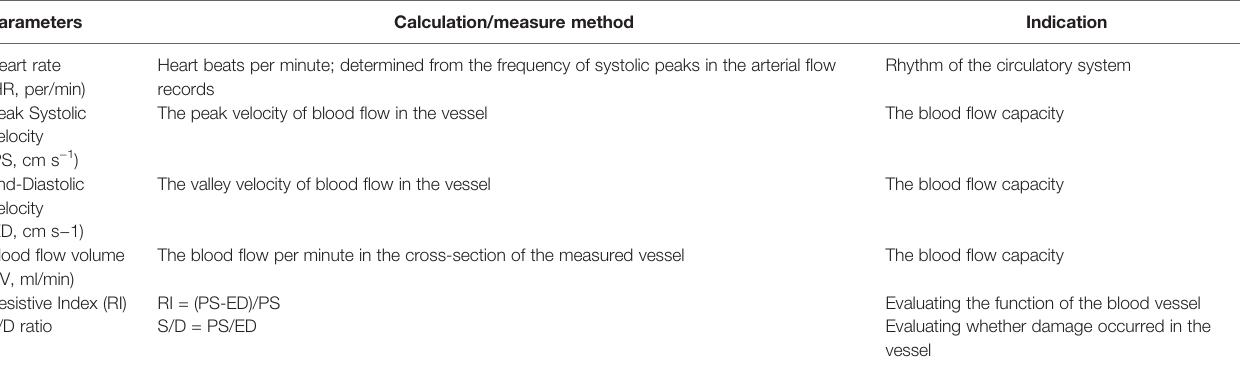
TABLE 1 | Listing of cardiac and hemodynamic parameters measured by ultrasonography. Parameters